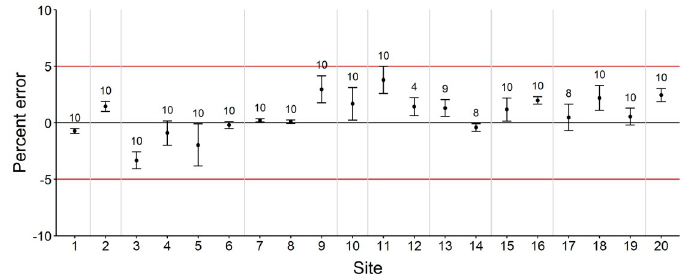
Fig 5. Field experiment length estimate error plot for objects of known length. Mean percent error estimated for objects of known length from paired still images obtained with SCs at BD1 (406 mm) mounted to an ROV deployed at reef sites (n = 20) in the northern Gulf of Mexico in 2018. Error bars indicate ± 1 standard error of the mean. The number of observations is shown above each estimate. Horizontal red lines indicate the ± 5% error threshold. Object length estimates for sites 1–4 and 20 were for a 603.3 mm PVC pipe, sites 5–10 were for the diameter of a PVC disc (274.6 mm dia), and sites 11–19 were for a 364.0 mm PVC pipe. Vertical gray lines bracket length measurements estimated with each set of calibration